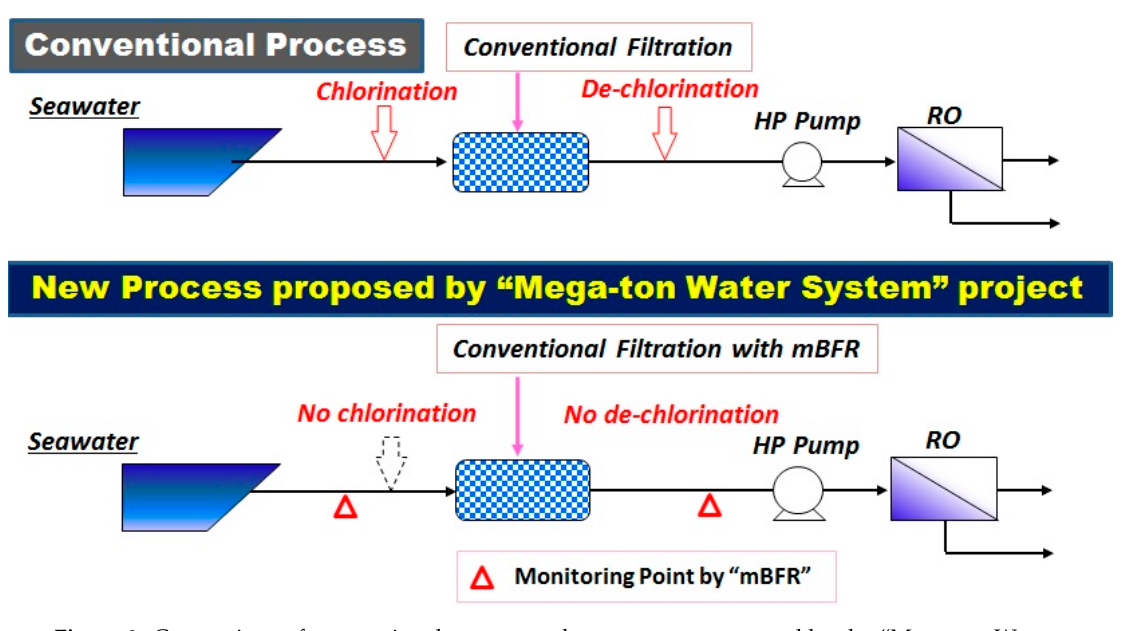
Figure 9. Comparison of conventional process and new process proposed by the “Mega-ton Water System”